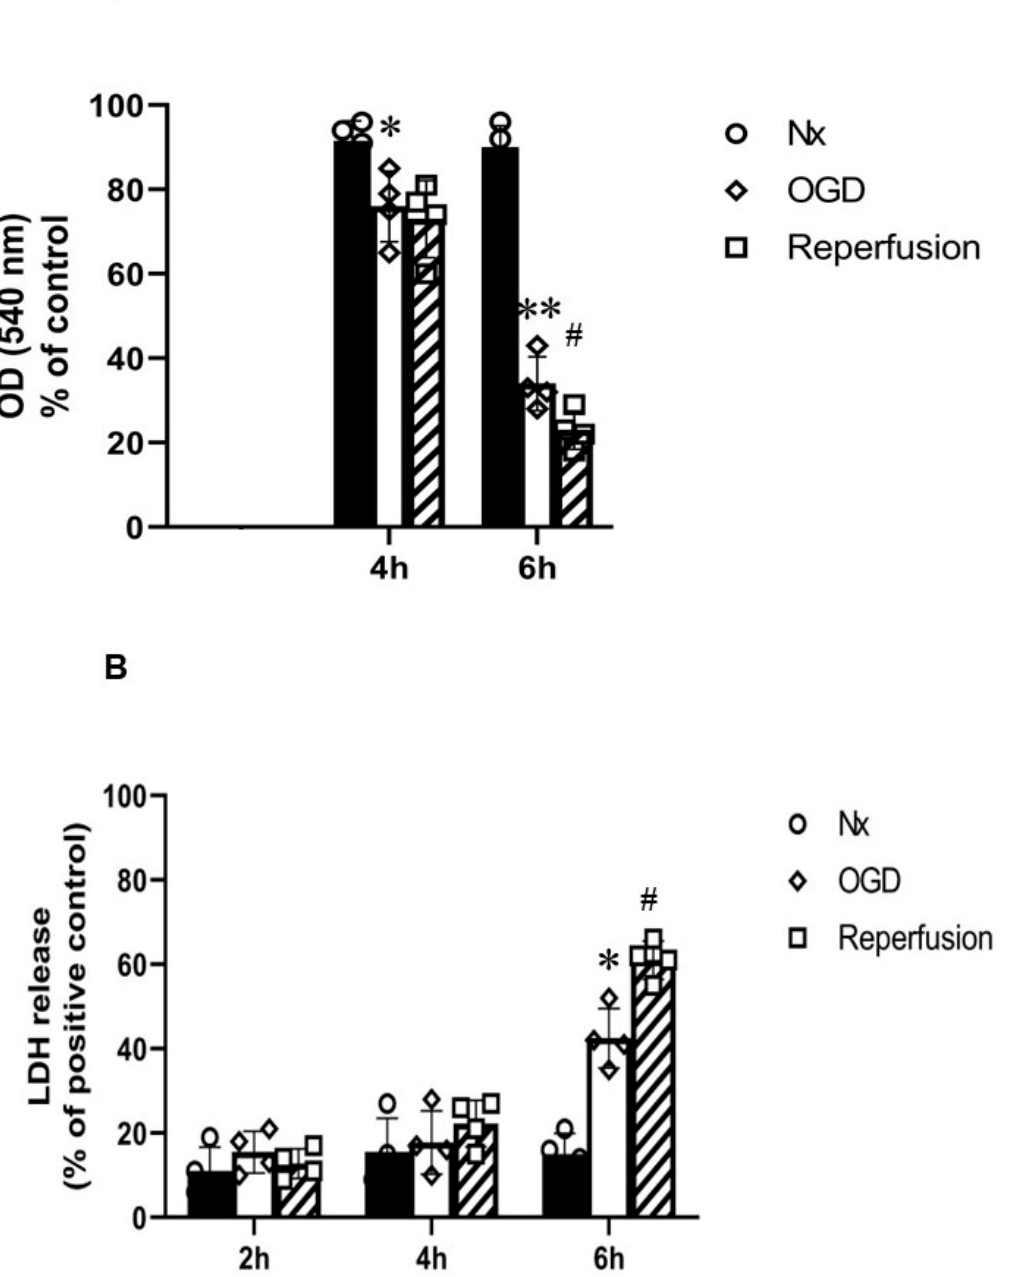
Figure 8. Primary rat cortical neurons in normoxia (Nx) and subjected to oxygen–glucose deprivation (OGD) before and after reperfusion. ( A ) MTT assay ( n = 4) showed significant reduction in MTT activity over time in primary neurons subjected to 4 and 6 h OGD. A further reduction in MTT activity was found with 24 h reperfusion after 6 h OGD; ( B ) LDH assay ( n = 4) showed significant increase in LDH release at 6 h OGD, and a further significant increase in LDH release after 24 h reperfusion. Error bars represent ± S.D. * Indicates p < 0.05, ** p < 0.01, against Nx controls; # indicates p < 0.05 for comparison of the treatments of OGD and reperfusion.